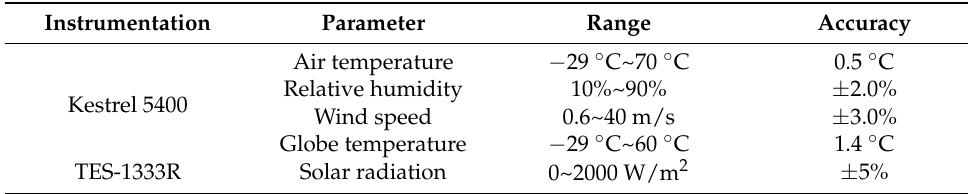
Table 2. Details of the equipment used to measure